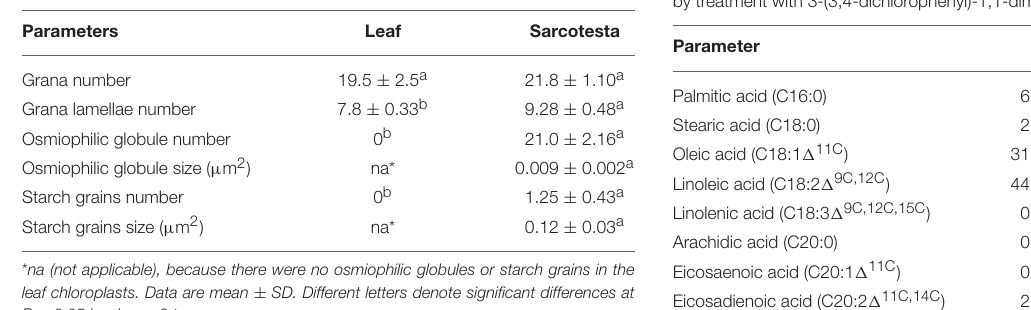
TABLE 2 | Chloroplast characteristics in leaves and sarcotesta of Torreya grandis cv. “Merrillii” at 81 days after seed protrusion in 2015 (DASP = 81 days).